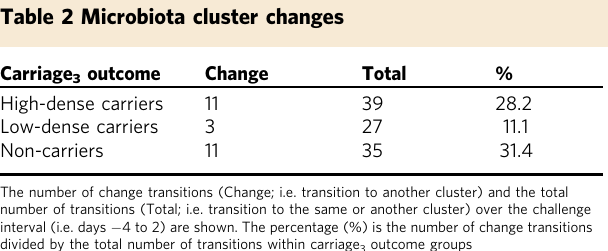
Fig. 4 Associations between cytokine levels and nasal microbiota at baseline. Using canonical correspondence analysis (CCA) ( a ) and distance-based redundancy analysis (dbRDA) ( b ), we assessed the links between cytokine levels day 0 and baseline nasal microbiota. It is assumed that the dependent variables (log 10 + 1-transformed relative abundance operational taxonomic units [OTUs]) respond in a unimodal or linear fashion to the predictor variables (log 2 -transformed cytokine levels) for CCA and dbRDA, respectively. We simultaneously plotted the samples (data points, n = 71), signi fi cant ( p < 0.05) predictor variables (cytokines; arrows) and the OTUs that were most strongly associated with the fi rst two axes ( n = 10 for each axis, excluding overlapping OTUs). Samples were coloured according to carriage 3 outcome (red, high-dense carriers, n = 36; blue, non-carriers, n = 18 and orange, low- dense carriers, n = 17), ellipses denote the standard deviation of the samples in each group. Note that carriage 3 outcome was not accounted for when